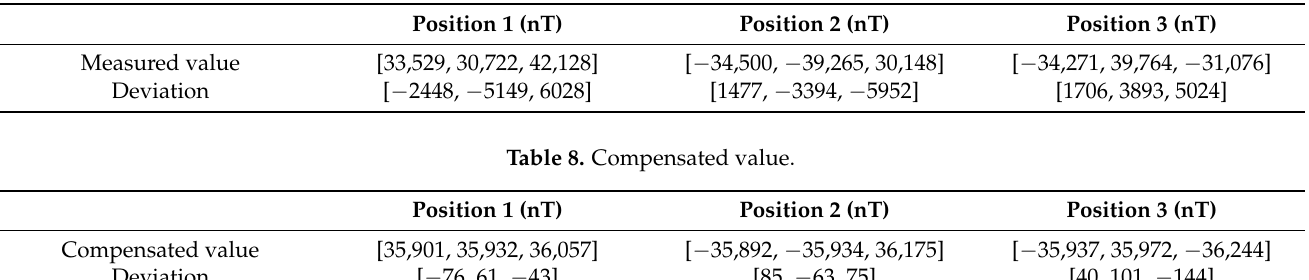
Table 7. Measured value before compensation.